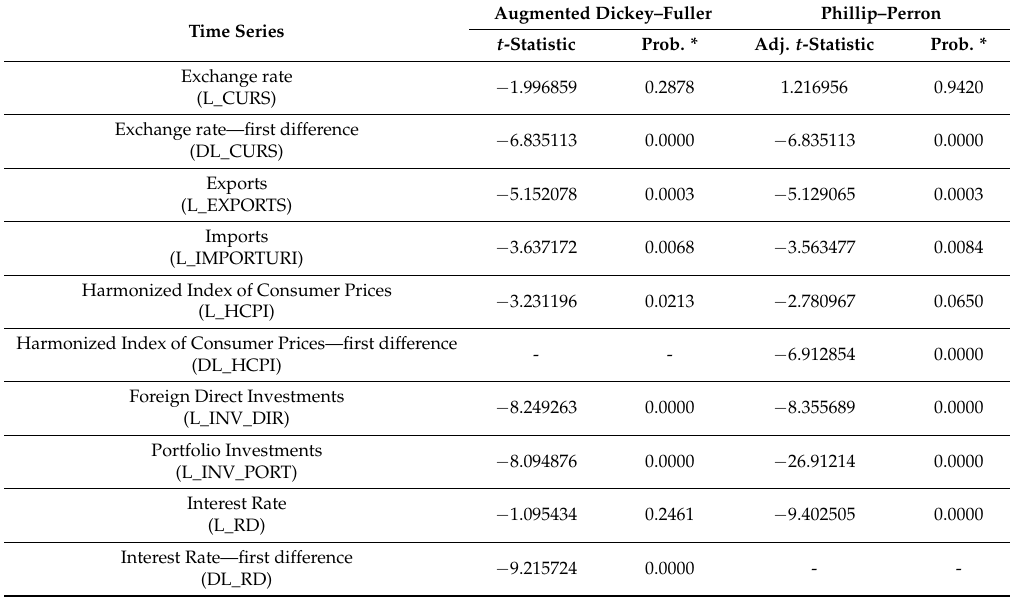
Table 1. Results of Augmented-Dickey–Fuller and Phillips–Perron stationarity